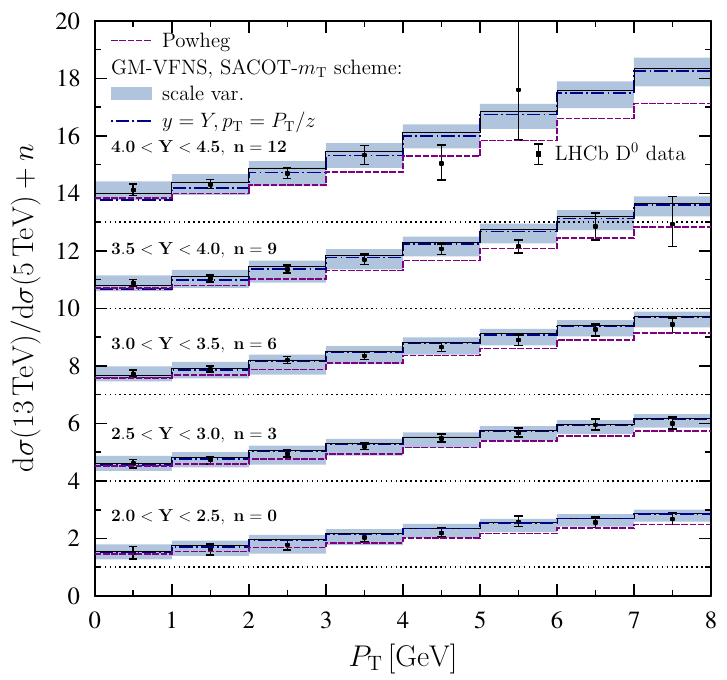
Figure 14 . As the upper panel of (cid:12)gure 13, but without the PDF uncertainties. Also the predictions ignoring the mass dependence in the fragmentation variable z are shown for comparison (blue dashed-dotted